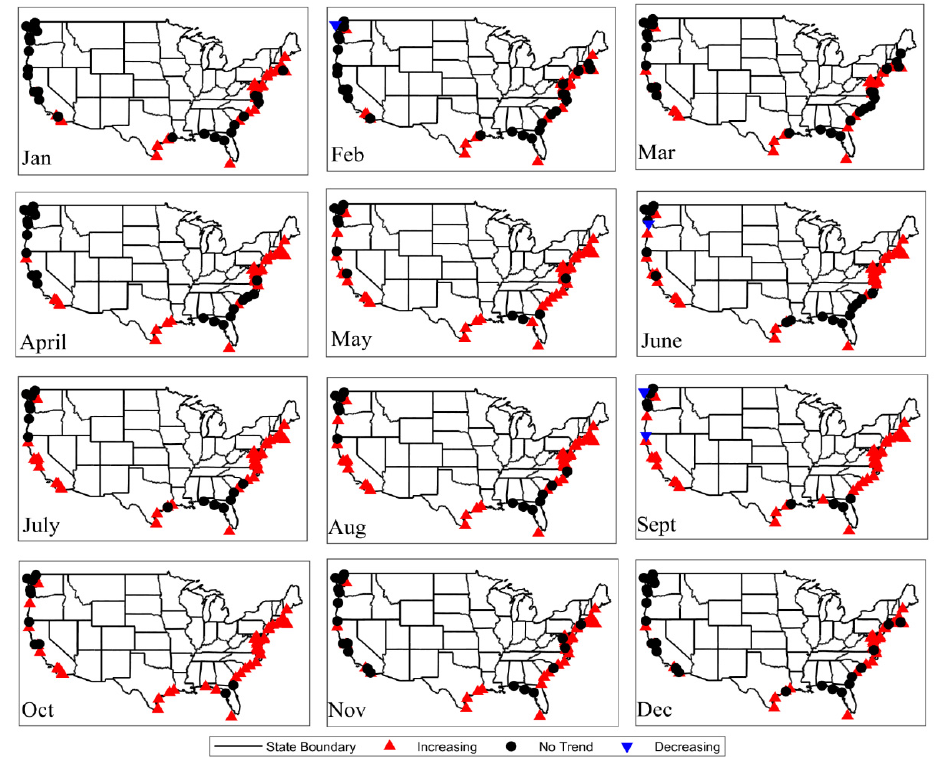
Figure 3. Spatial plots showing the MK2 trend significance of monthly sea level along the coastal US accounting STP. The red upward arrow represents an increasing/positive trend whereas the blue downward arrow represents a decreasing/negative trend. The black dot represents stations showing no trend at the statistical significance of p ≤ 0.05.